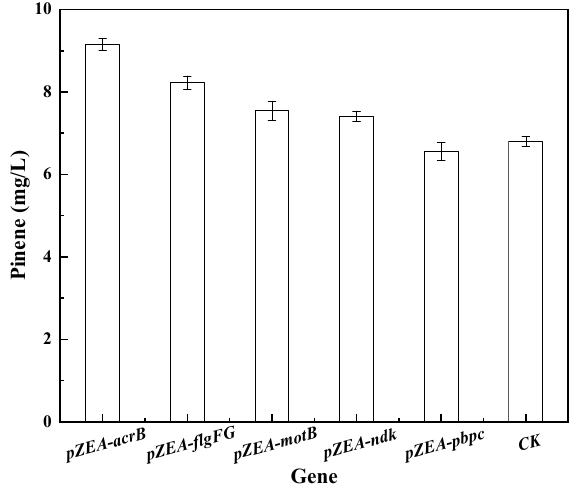
Figure 3. Effect of overexpression of selected genes on pinene production. Expression of plasmid in E. coli MG1655 (pMEVIGPS). E. coli MG1655 (pZEABP and pMEVIGPS) was set as the control (CK).